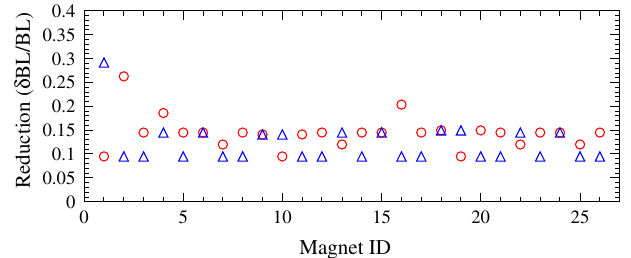
FIG. 7. (Color) Calculated field reduction rates of the horizontal (red circles) and vertical (blue triangles) steering magnets caused by the magnetic